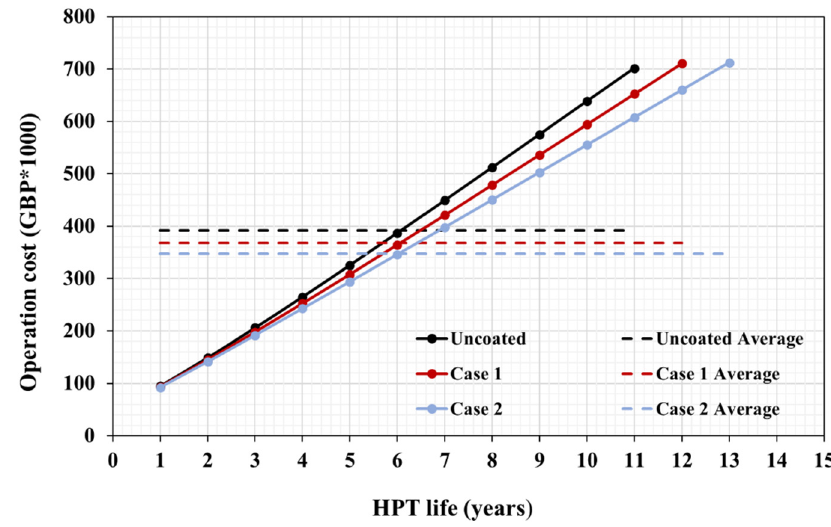
Figure 6. HPT operational cost, useful life and representative average.